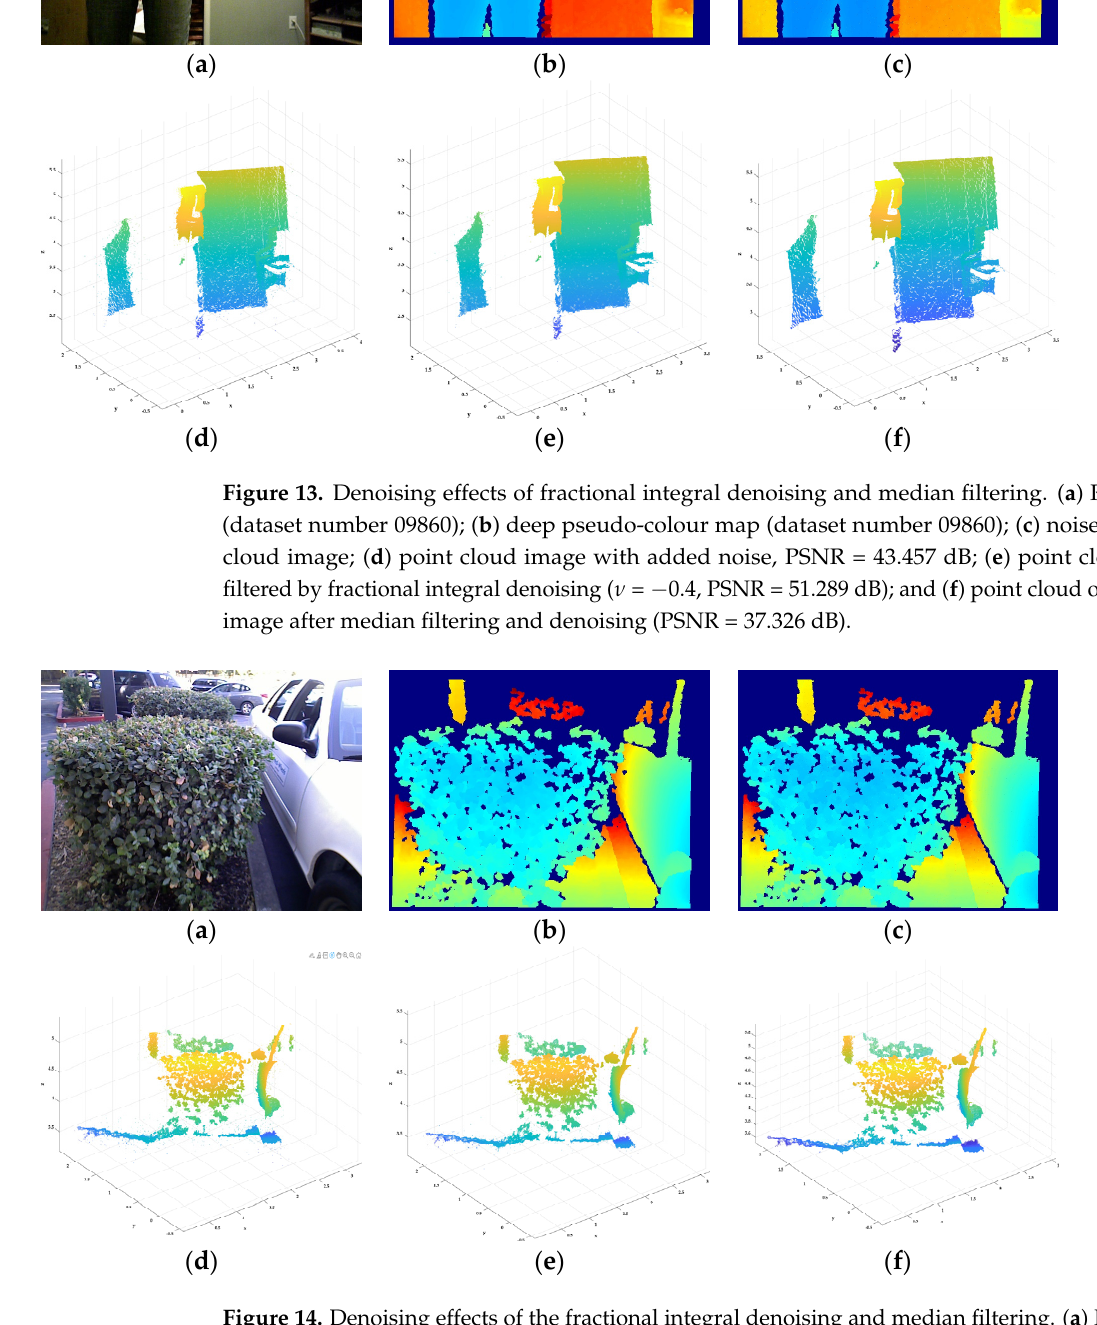
Figure 14. Denoising effects of the fractional integral denoising and median filtering. ( a ) RGB image (dataset number 08343); ( b ) deep pseudo-colour map (dataset number 08343); ( c ) noise-free point cloud image; ( d ) point cloud image with added noise, PSNR = 46.934 dB; ( e ) point cloud image filtered by fractional integral denoising ( ν = − 0.3, PSNR = 50.870 dB); and ( f ) point cloud of the depth image after median filtering and denoising (PSNR = 32.112 dB).